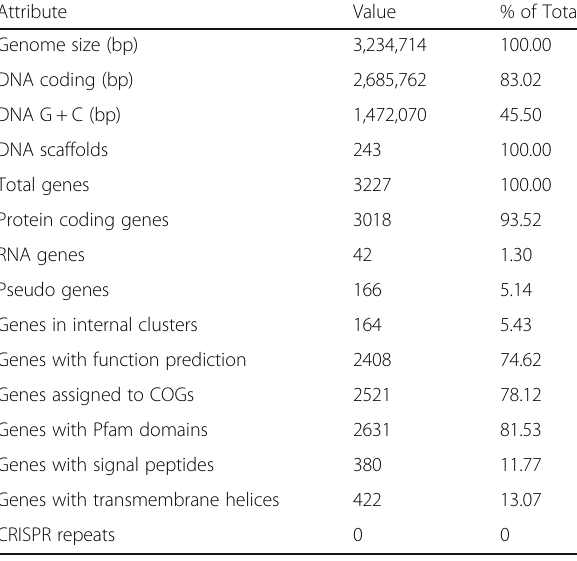
Table 3 Genome statistics of B. abortus strain Ba Col-B012 Attribute Value